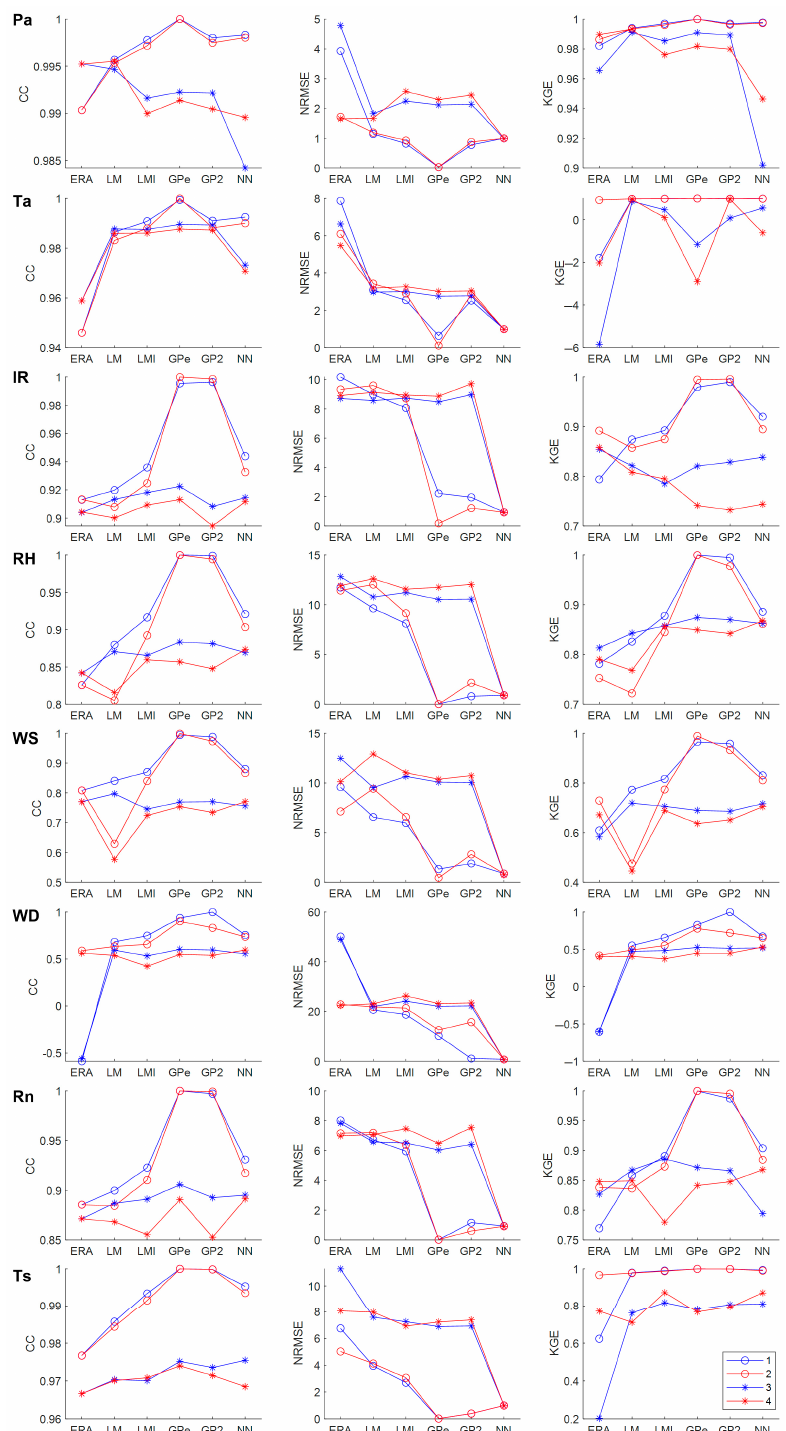
Figure 5. Model performance ( CC , NRMSE , and KGE ) for meteorological variables. Pa—air sur- face pressure (hPa), Ta—air temperature ( ◦ C), PAR—incoming photosynthetically active radiation ( µ mol/m 2 /s), RH—relative air humidity (%), WS—wind speed (m/s), WD—wind direction (deg), Rn—net radiation (W/m 2 ), Ts—soil temperature at 5 cm ( ◦ C). 1—ERA dataset the testing phase; 2—PCA dataset the testing phase; 3—ERA dataset the validation phase; 4—PCA dataset the valida- tion